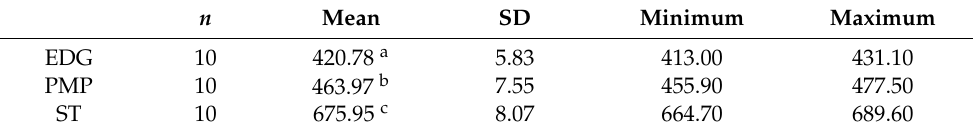
Table 4. Descriptive statistics regarding time to failure of the novel brands of NiTi alloy endodontic